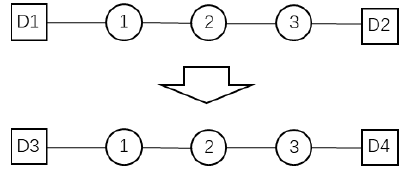
Figure 3. Cyclic exchange with three routes ([50]).